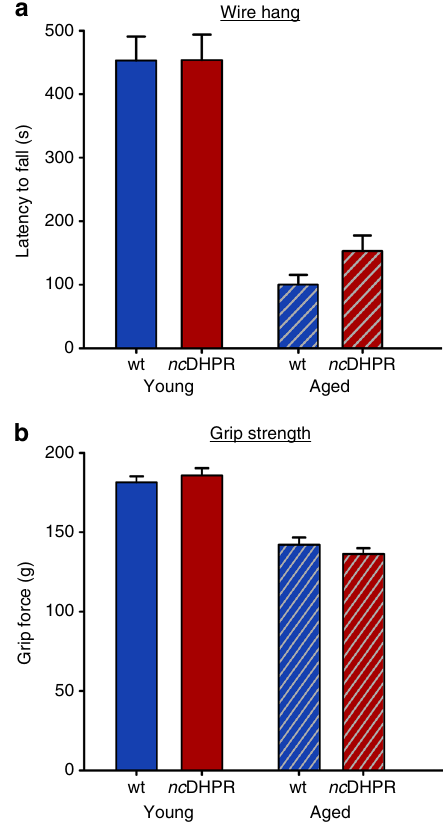
Fig. 7 DHPR Ca 2+ in fl ux has no impact on whole animal muscle coordination and strength. a nc DHPR mice performed equally well similar to control littermates in wire hang test set for 600 s. The mean latency to fall from the cross-wired grid was similar between young nc DHR (453.85 ± 39.97 s; n = 26) and wt (453.04 ± 38.06 s; n = 25) mice, as well as between aged nc DHPR (153.12 ± 24.82 s; n = 25) and wt (100.44 ± 15.06 s; n = 27) mice. b The mean grip strength, an index of maximal muscle force of forelimbs, was not different in young (185.68 ± 4.71 g ; n = 15) and aged (136.39 ± 3.59 g ; n = 23) nc DHPR mice compared with their age-matched wt littermates (young wt: 181.38 ± 3.88 g ; n = 6; aged wt: 142.29 ± 4.34 g ; n = 27 mice). Normal age-dependent deterioration in muscle strength is evident in both genotypes. Bars represent mean ± s.e.m.; P determined by unpaired Student ’ s t wt mice displayed equal performance (20.07 ± 0.81 rpm and 20.01 ± 1.22 rpm, respectively). Next, we designed a prolonged Rotarod protocol (600 s) at constant speed (20 rpm for young and 15 rpm for aged mice) to access endurance. Latency to fall dis- played by young nc DHPR mice was comparable ( P > 0.05, unpaired t -test) to their wt counter mates (Fig. 8b, right two bars ).